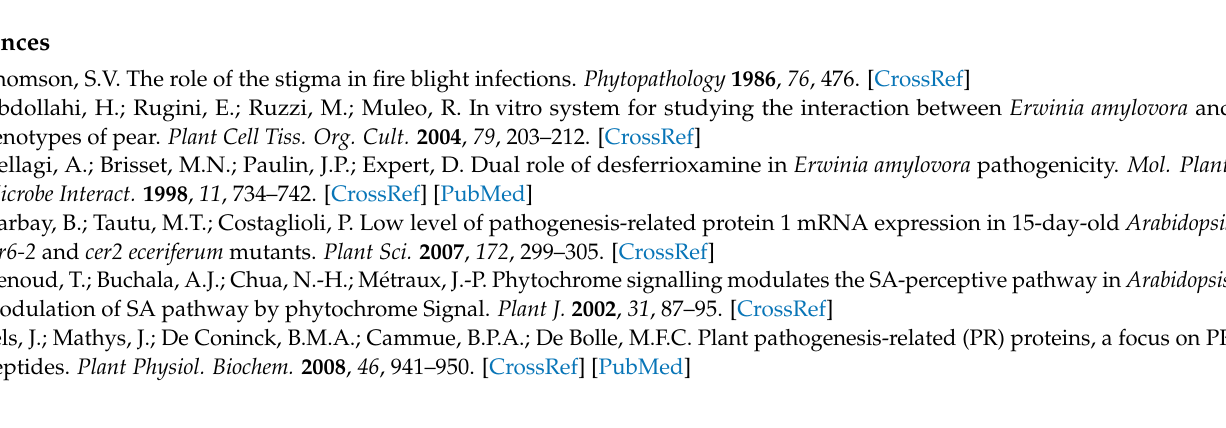
BL, Figure S4: Dar Gazi events of regenerations after 25 days in dark condition (a). Shoots were four/five times for rapid and clonal multiplication (b). The medium used for the in vitro selection of proliferation state, Figure S5: Detection of ef1A gene fragments in cDNA of Dar Gazi-wt , Dar